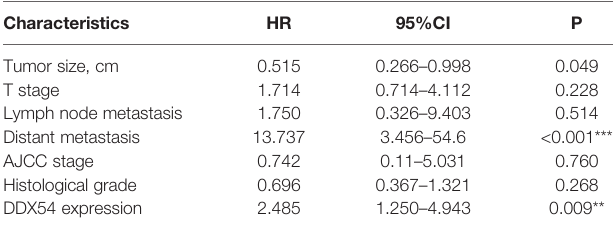
TABLE 2 | Univariate Cox regression analysis of potential prognostic factors for colorectal cancer patients. Characteristics